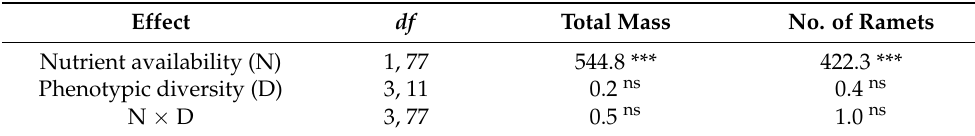
Table 1. Effects of nutrient availability and phenotypic diversity on total mass and number of ramets of the populations of Spirodela polyrhiza for the second phase of Experiment